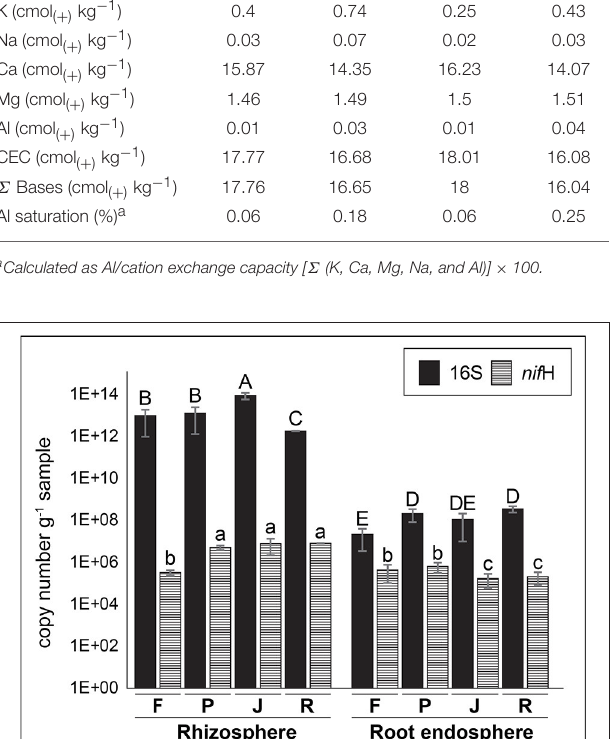
( Figure 3 ), except for sequences from Chitinophaga sp. 643EA and Roseomonas sp.